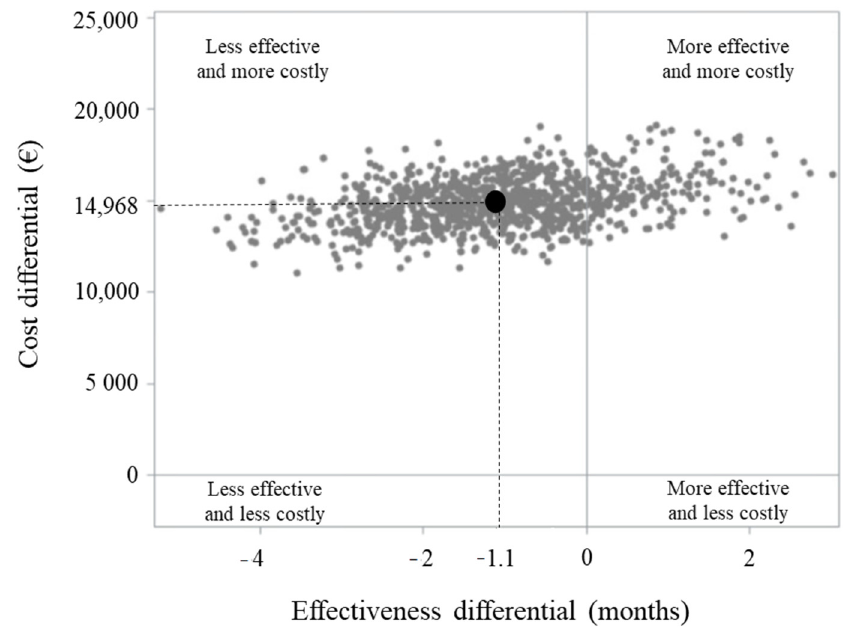
Figure 4. Incremental cost-effectiveness ratio (ICER) scatterplot comparing metastatic colorectal cancer cohort members on first-line treatment with biologic-based (bevacizumab or cetuximab, Bio + CT) or standard chemotherapy (CT) alone. FABIO project, Lombardy Region, 2010–2014.